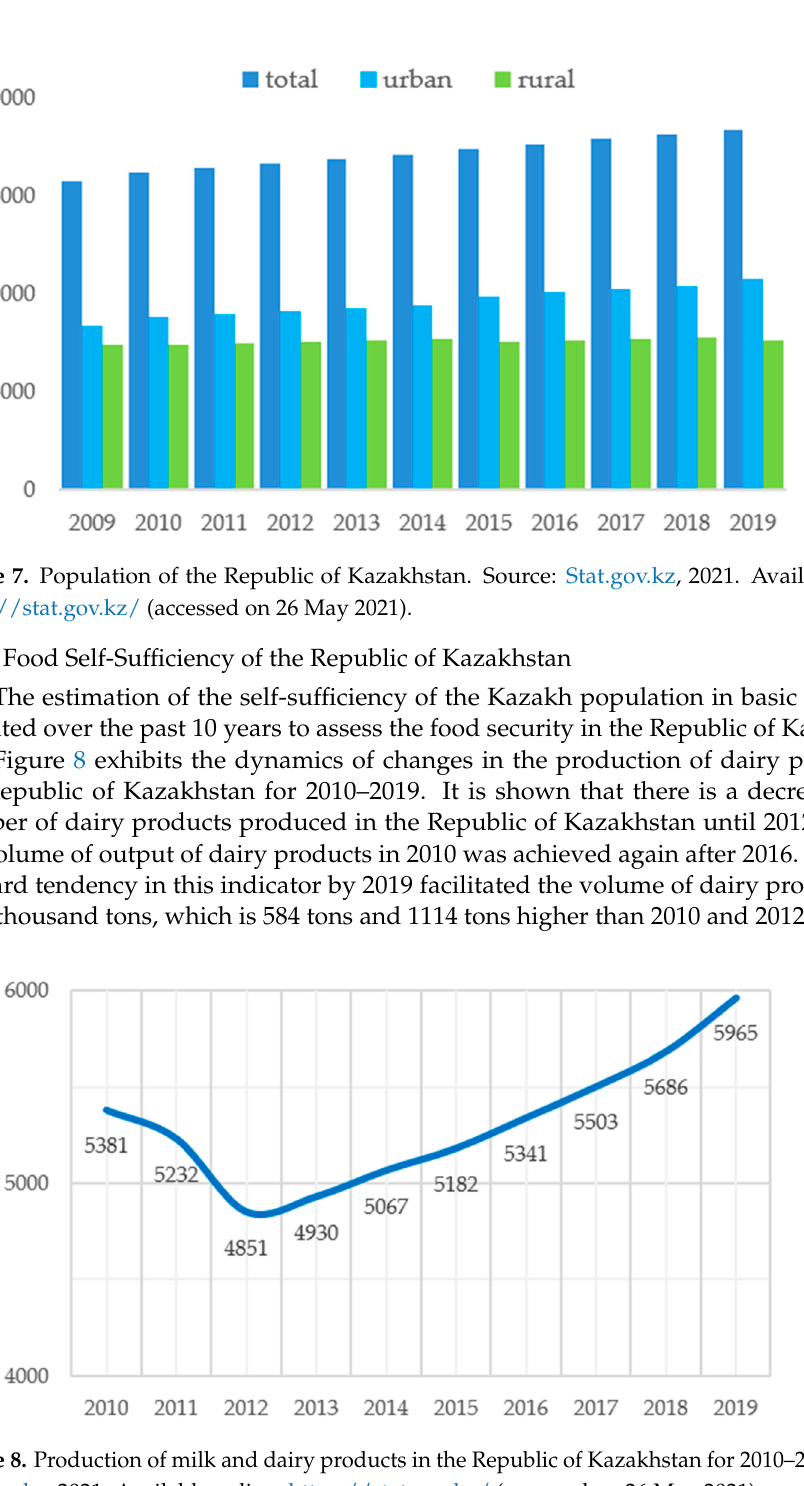
Figure 8. Production of milk and dairy products in the Republic of Kazakhstan for 2010–2019.